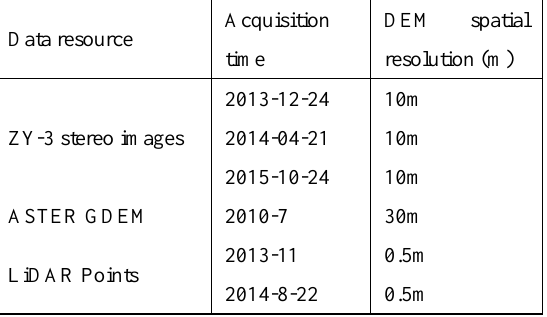
Table 1 Data sets used in this paper.